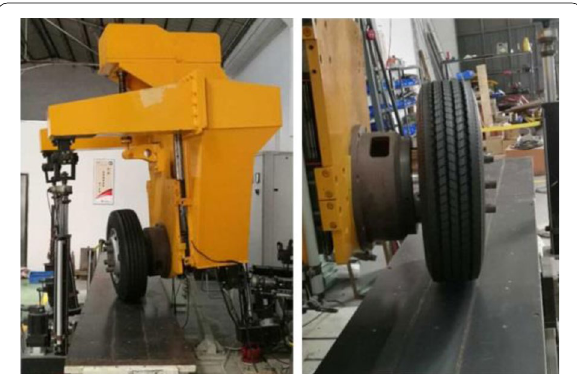
Figure 1 Experimental setup of the tire mechanical characteristics tests